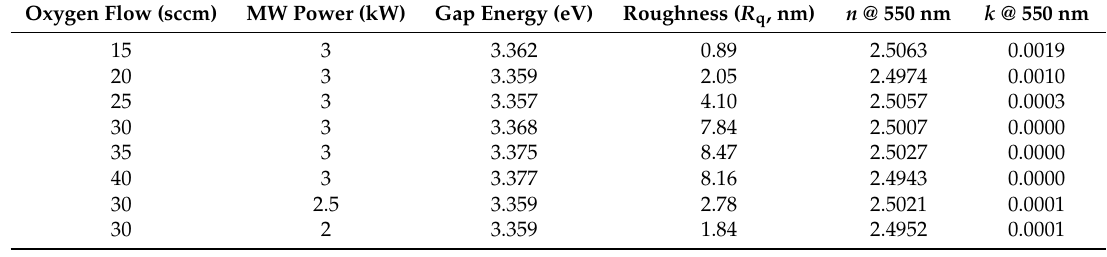
Table 3. List of selected parameters obtained through data fitting for TiO 2 thin films.